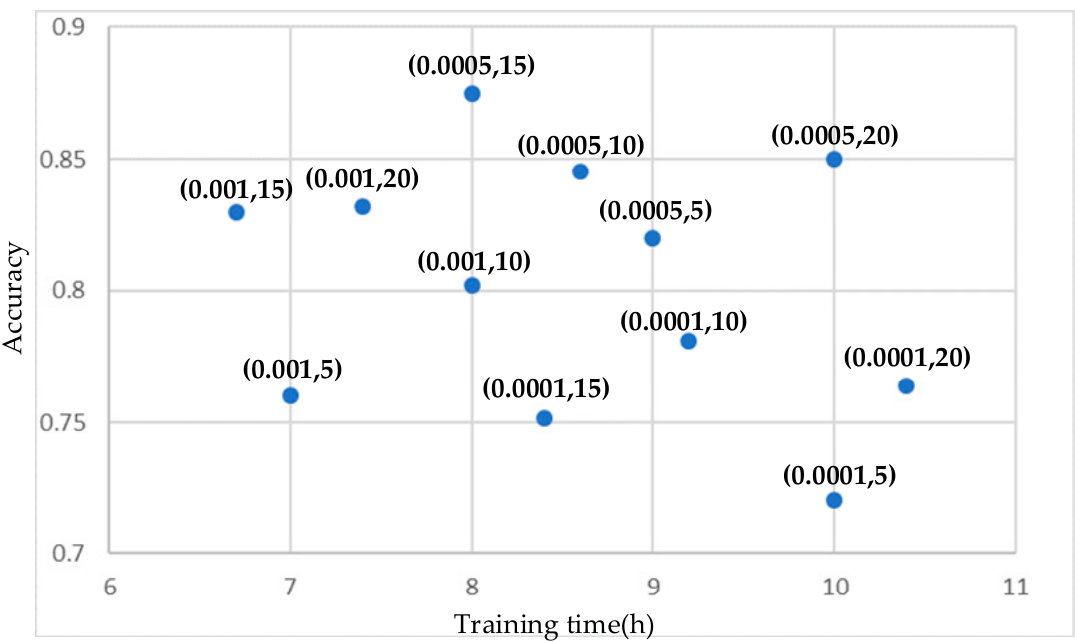
Figure 11. The validation accuracy and training time under different model parameters.